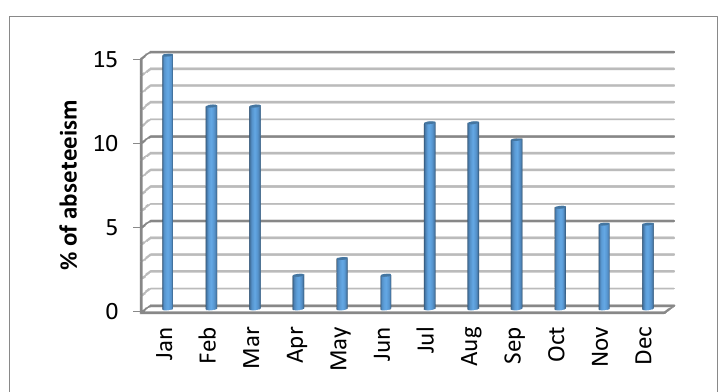
Fig. 10. Hospital expenditure in year 2018.